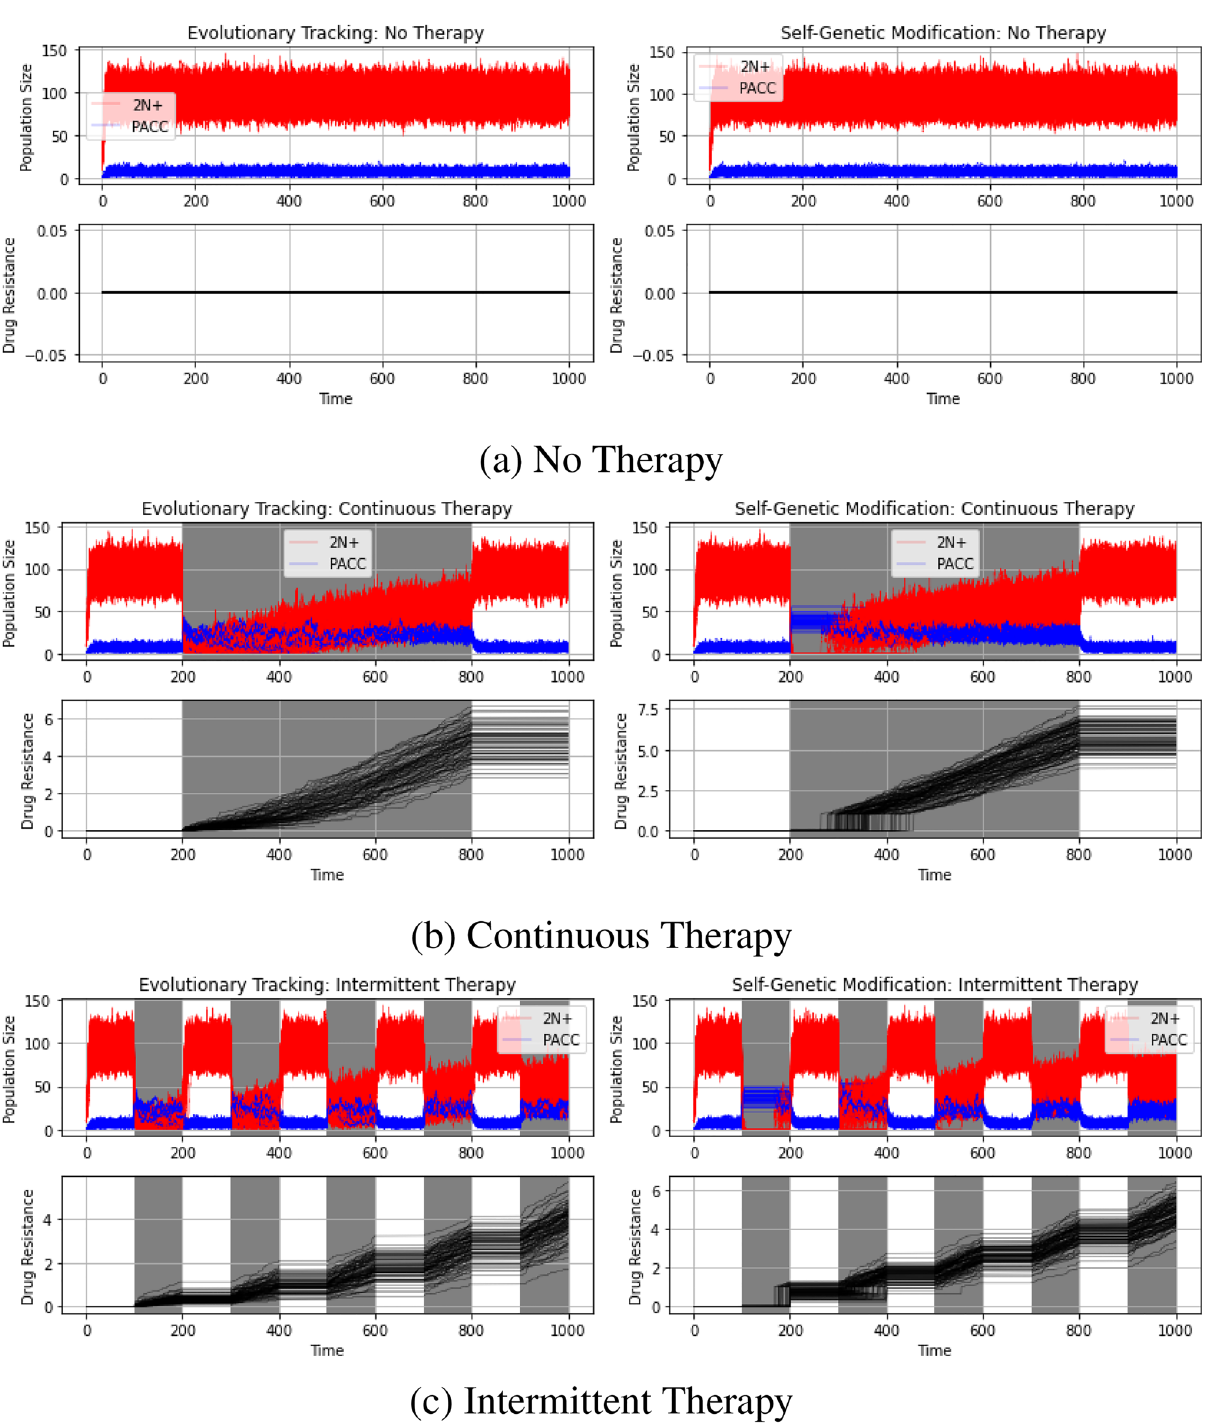
Figure 3. No therapy ( a ), continuous therapy ( b ), and intermittent therapy ( c ) under evolutionary triage and self-genetic modification. Under SGM, the stable PACC state allows cells to persist under therapy and buys them enough time to evolve adequate levels of resistance and avoid extinction. Under ET, in most cases, the cells are able to evolve resistance quickly enough to avoid extinction; however, extinction still occurs in a minority of